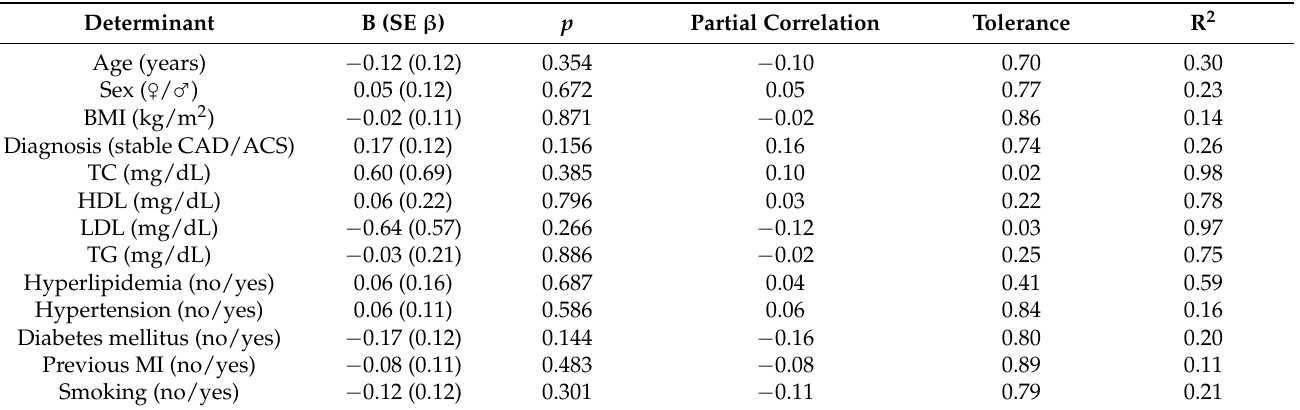
Table 3. Multivariable regression analysis for Cu.